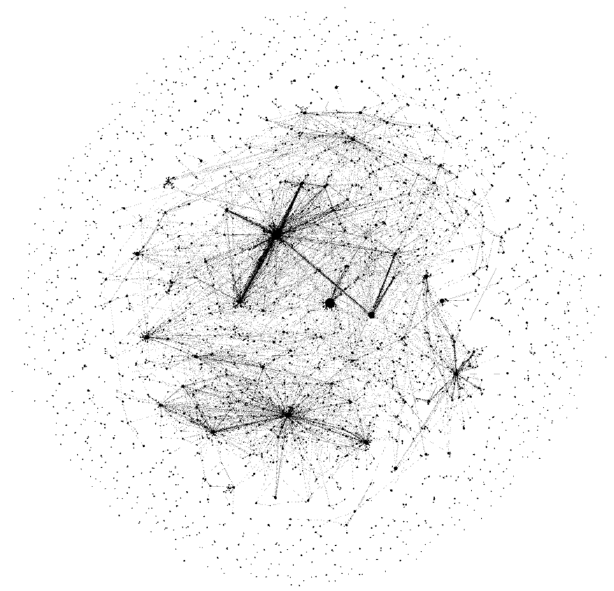
Figure 10. Graph of the compiled medical knowledge base.